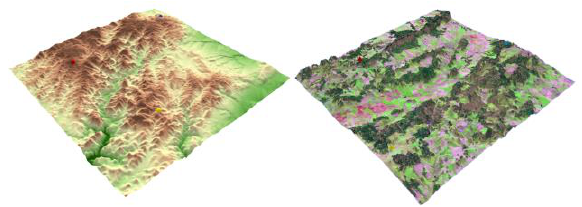
Fig. 4. An example of stimuli from variant A – terrain covered with a hypsometric scale (left) and variant B – terrain covered with a satellite image